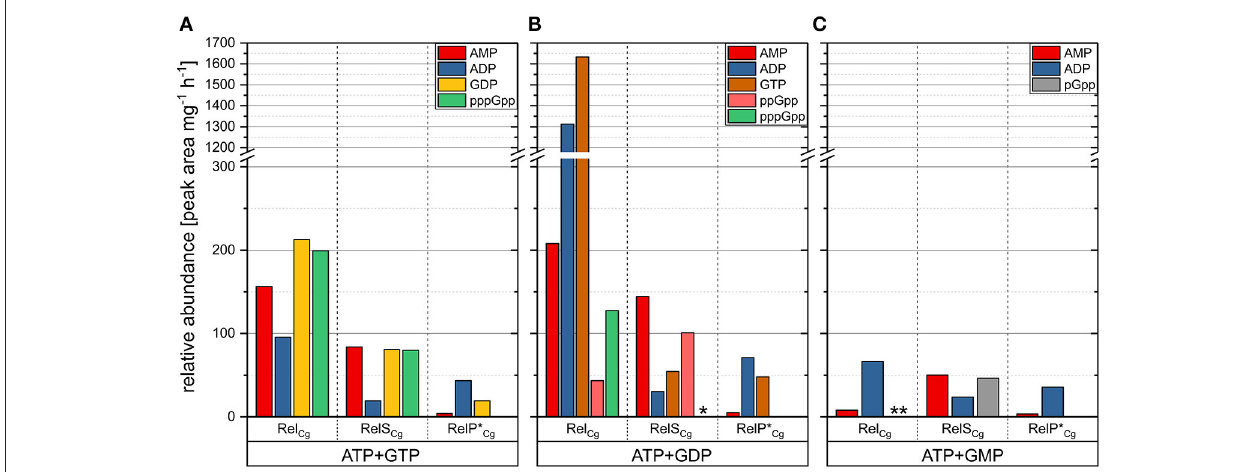
FIGURE 4 | In vitro activity characterization of the putative (p)ppGpp synthetases RelP* Cg and RelS Cg , as well as the enzyme Rel Cg . Graphical representation of the HPLC analysis of 50 µ L assay reactions containing 500 ng of the corresponding enzyme and ATP + GTP (A) , ATP + GDP (B) and ATP + GMP (C) as substrate combinations with a concentration of 4 mM each. HPLC separation was performed using a SeQuant ZIC-pHILIC column and isocratic elution with 38% of 10 mM ammonium bicarbonate buffer (pH 9.3) and 62% acetonitrile. The reaction products were identified by their specific masses and retention times. Their relative abundance is given as the peak area of the UV signal (252 nm) per mg of the respective enzyme per hour. The results shown were corrected by the values determined for enzyme-free controls. For some measurements pppGpp (*) or pGpp (**) were detected by their characteristic MS signals, but the UV detection limits were not